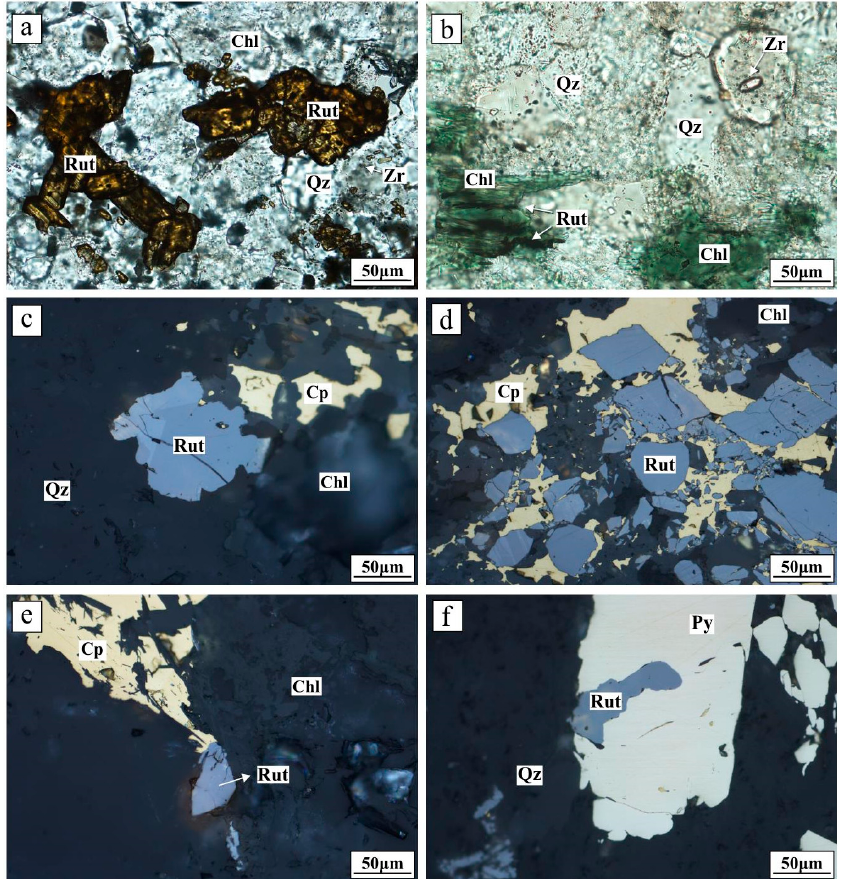
Figure 3. Microphotographs of samples from the Tuwu porphyry Cu deposit. ( a ) Rutile enclosed within quartz (transmitted light); ( b ) rutile coexisting with quartz, zircon, and chlorite (transmitted light); ( c ) rutile crystal coexisting with chalcopyrite, quartz, and chlorite (reflected light); ( d ) fragmented rutile intergrown with chalcopyrite (reflected light); ( e ) subhedral rutile intergrown with chalcopyrite (reflected light); and ( f ) anhedral rutile included within pyrite (reflected light). Abbreviations: Chl = chlorite; Cp = chalcopyrite; Py = pyrite; Qz = quartz; Rut = rutile; Zr = zircon.